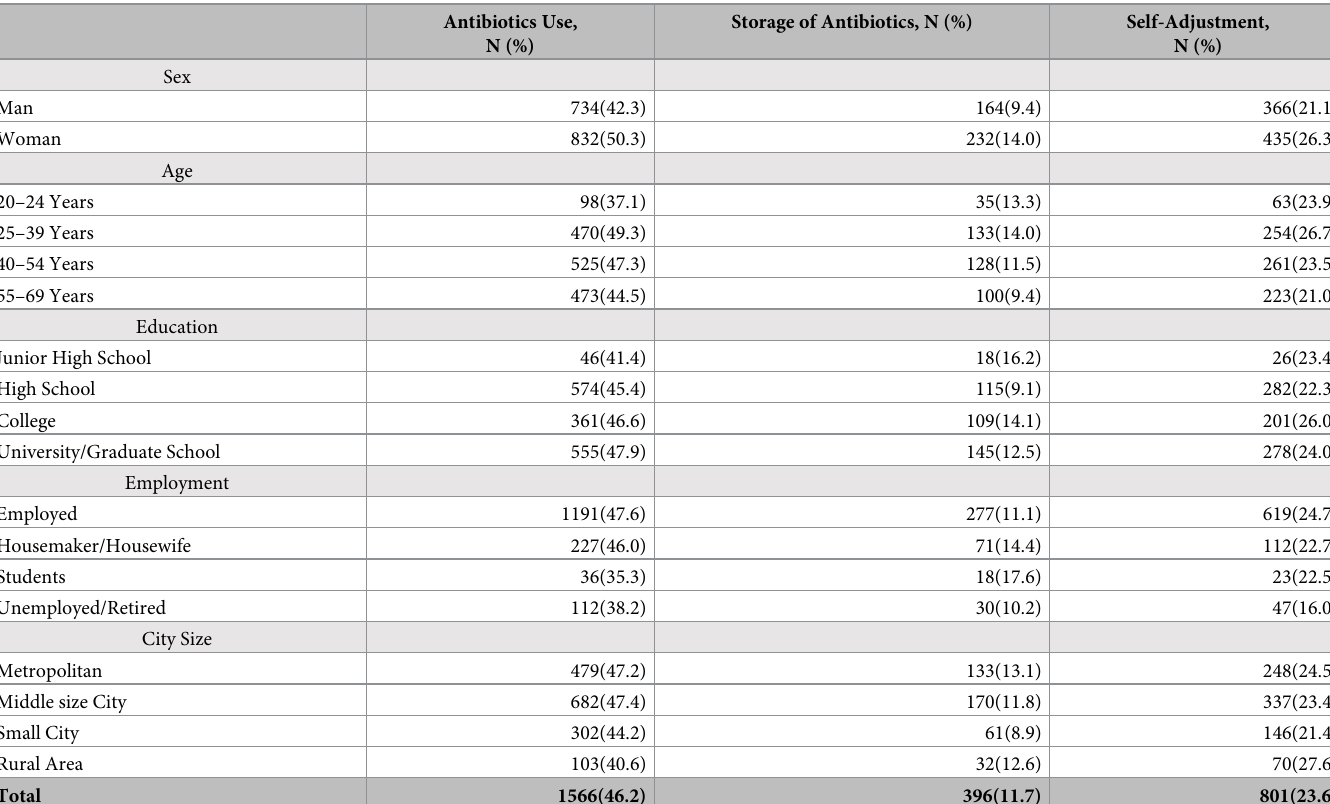
Table 2. Use, storage and adjustment of